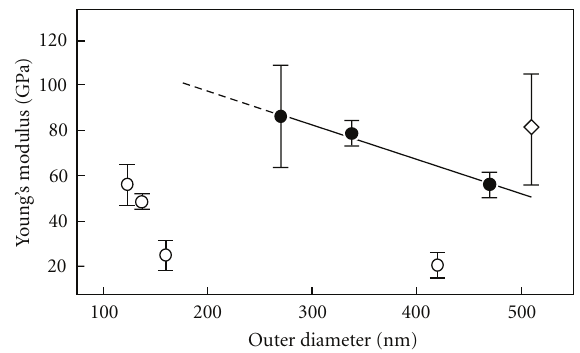
Figure 5: Young’s modulus of single-crystal C 70 nanotubes plotted against outer diameter. The values observed in the present study are indicated by the filled circles. The solid line indicates a linear approximation. For reference, Young’s moduli of single-crystal C 60 nanotubes and nanowhiskers are represented with rhombus and open circles, respectively [18, 19,